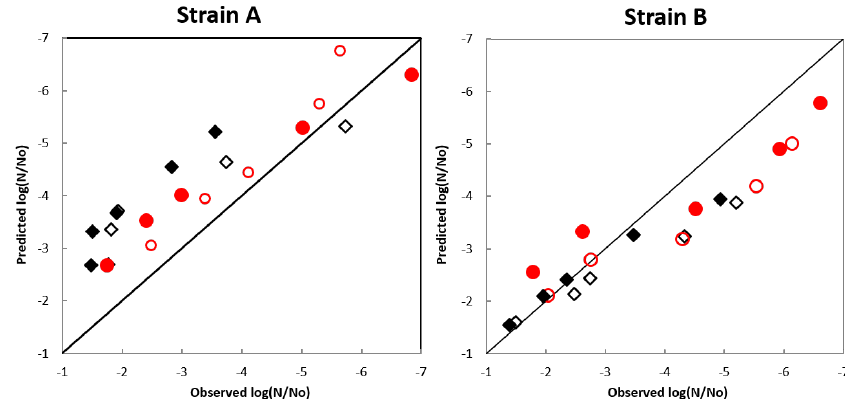
Figure 5. External validation for Weibull model correlating the observed and predicted values of Alicyclobacillus acidoterrestris spores when treated with the combination of 500 MPa at 55 °C ( ◇ ) and 65 °C ( ◆ ) and 600 MPa at 55 °C ( ○ ) and 65 °C (●).